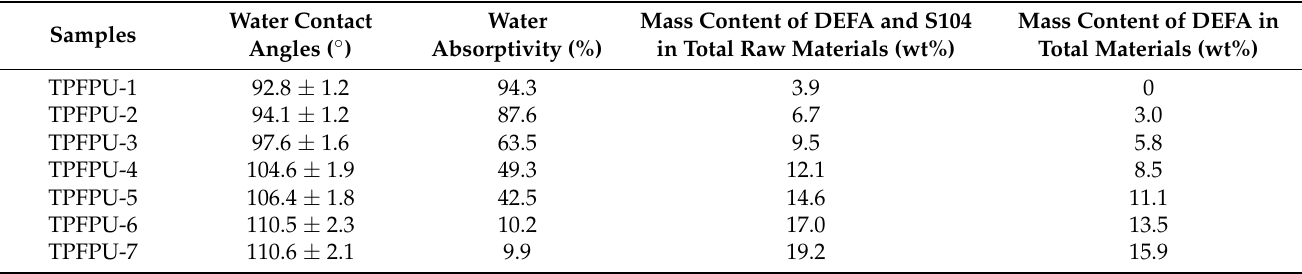
Table 4. Water contact angles, water absorptivity and theoretical mass content of DEFA and S104 or DEFA of the TPFPU latex